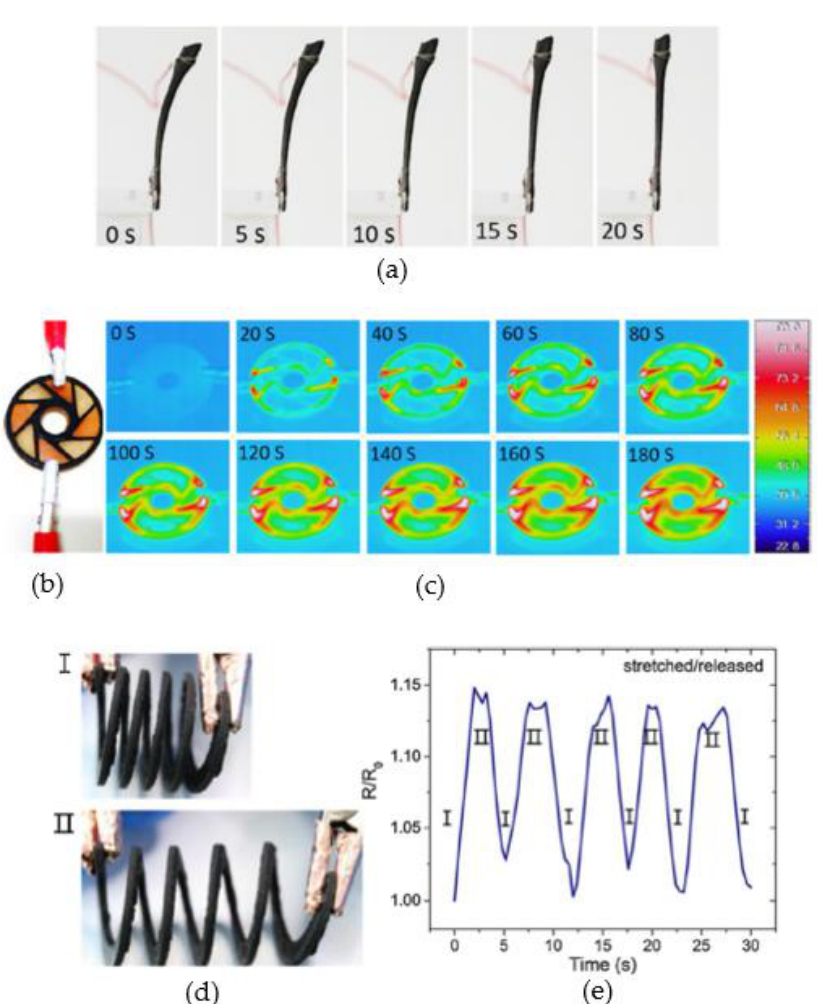
Figure 23. ( a ) Shape change of the sample during ohmic heating. ( b ) Optical image, ( c ) infrared images during heating. ( d ) Images of a stretchable spring structure in (I) released and (II) stretched. ( e ) Change in resistance of a representative gauge during five stretching/releasing cycles [64]. Copyright © 2022, Elsevier.